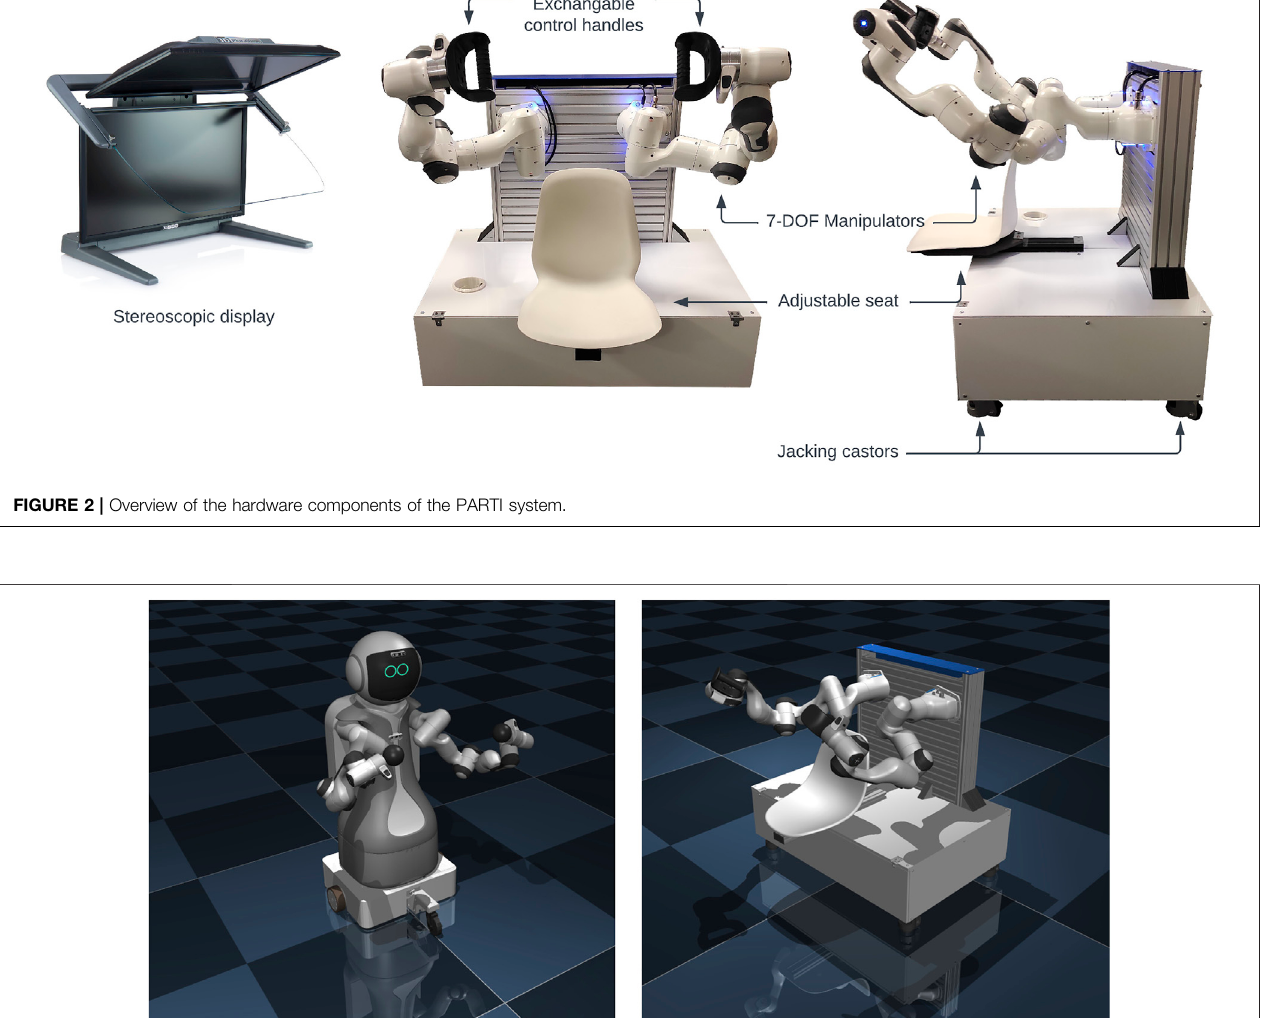
Frontiers in Virtual Reality |